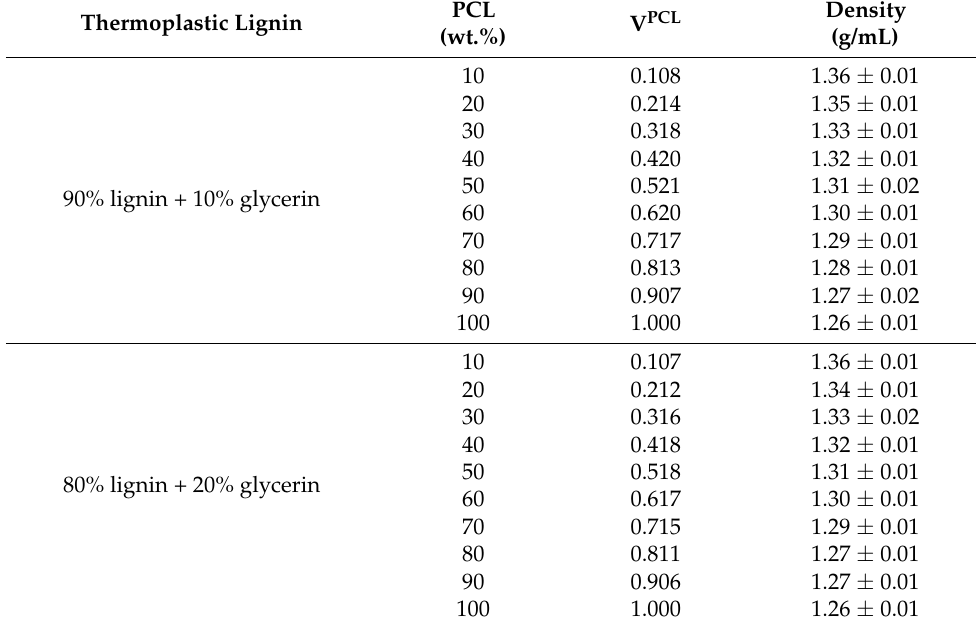
Table 5. Physical properties of thermoplastic lignin and PCL blends